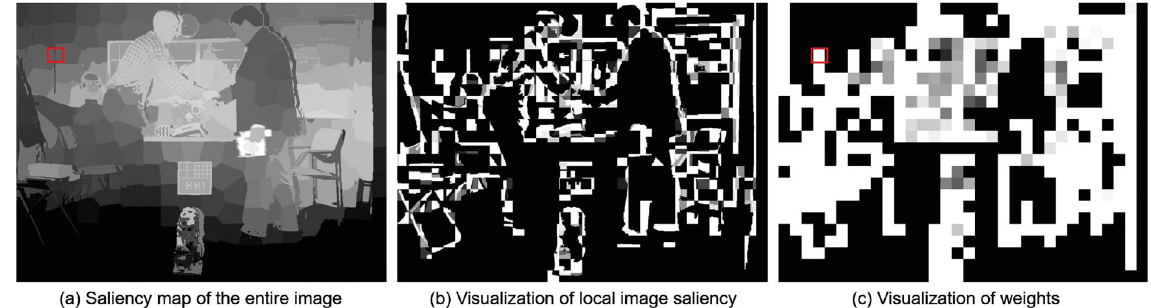
Fig. 8 Visualization of local image saliency based weighting. (a) Saliency map of the entire distorted image. (b) Merged saliency maps of the associated small image patches. All saliency maps were produced by Ref. [28]. (c) Local image saliency based weights, brighter blocks indicating higher weights.